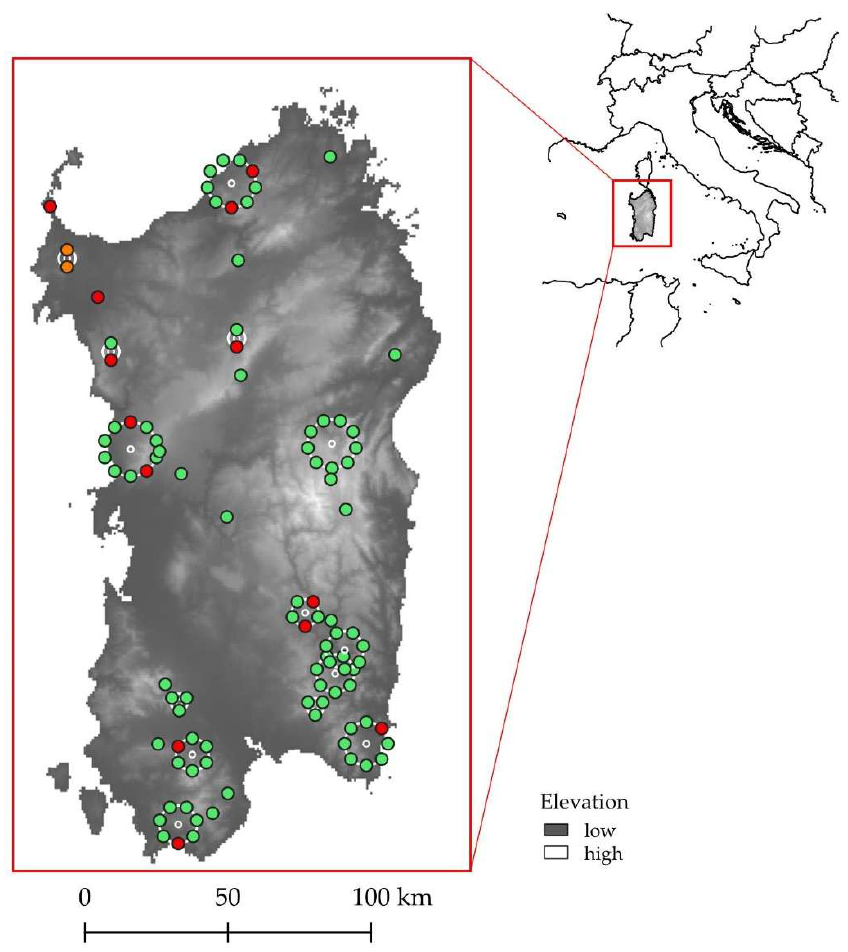
Figure 1. Sampling locations for the ninety-six Sardinian wild boars analyzed in this study. Samples collected in the same municipality are grouped in rings. Individuals excluded because of the initial quality filters are shown in red; the two individuals in the northwest excluded after the population structure analysis are shown in orange; the final dataset for the local adaptation tests is shown in